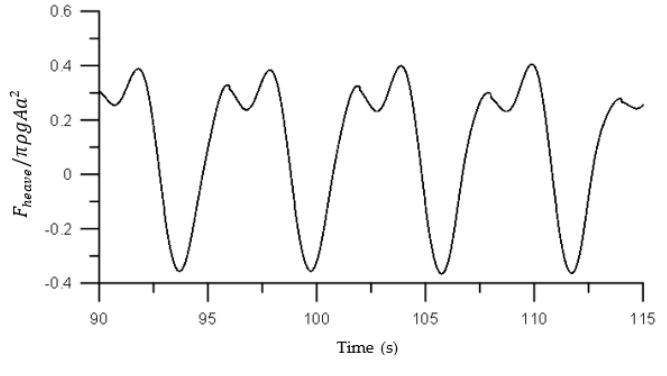
Figure 7. Time variation of the heave exciting force ( a ) and the heave motion ( b ) for the cylinder with 𝑎 = 5.0 m and 𝑏/𝑎 = 1.0 ( 𝑑 = 10.0 m) under the action of unit-amplitude nonlinear mono- chromatic waves of 𝑇 = 6.0 s.